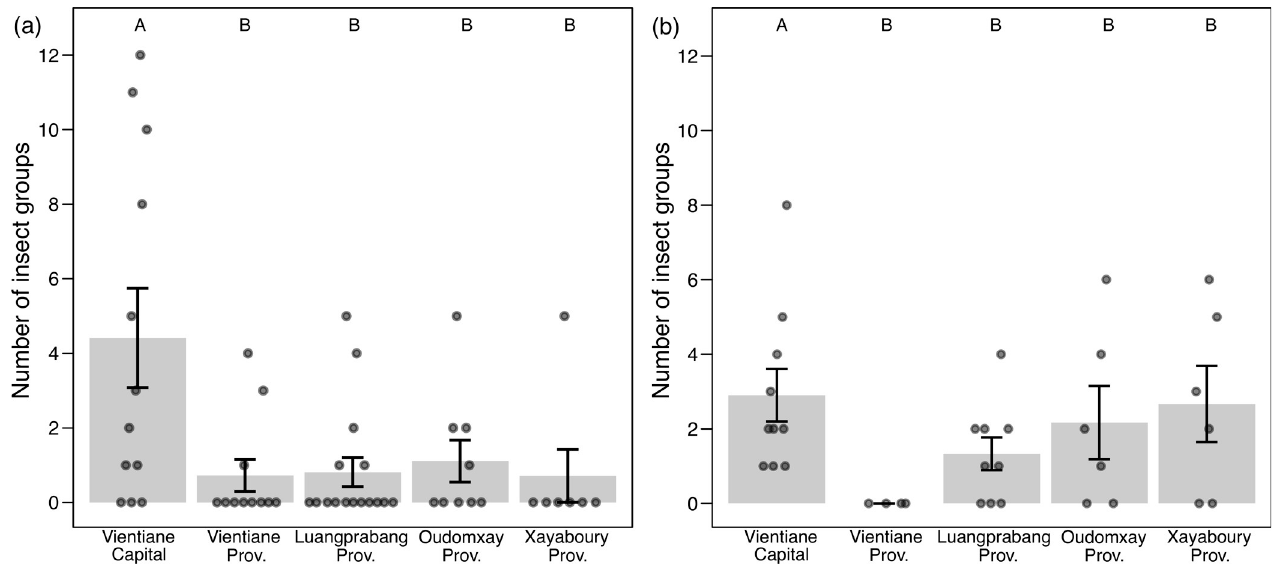
Fig 3. The number of groups of insects sold at food markets in each province and capital. (a) Dry season, (b) Rainy season. Circles indicate the number of insect groups sold at each market. Bars and whiskers indicate the mean and SD for each province and capital respectively. Letters above the figure indicate significant differences at 5% level (generalized linear models with Holm adjustments).